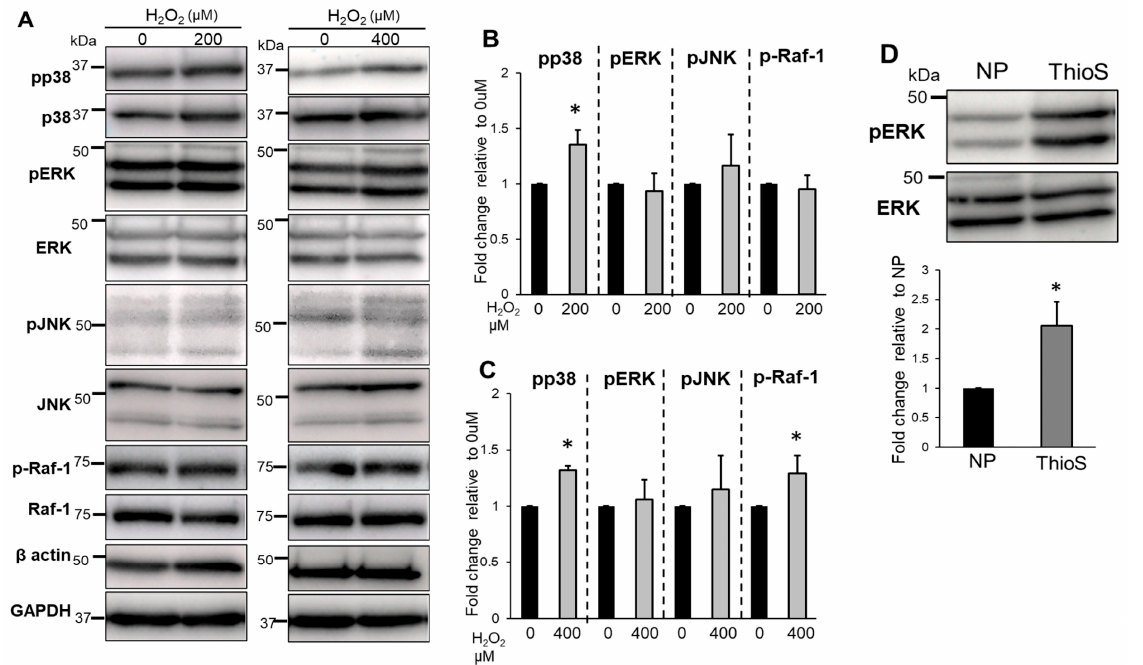
Figure 8. Evaluation of the phosphorylation of MAPK family members and Raf-1 in thioflavin-S- treated NP cells. Western blot analysis ( A ) and quantification ( B , C ) of the phosphorylated forms of p38, ERK, JNK, and Raf-1 in thioflavin-S-treated NP cells treated with or without H 2 O 2 for 30 min. Data are the means ± SD n = 3, * p < 0.05. ( D ) Comparison of the expression of pERK in NP cells (NP) and thioflavin-S-treated NP cells (ThioS) without H 2 O 2 treatment. Data are the means ± S.D. n = 3, * p < 0.05.